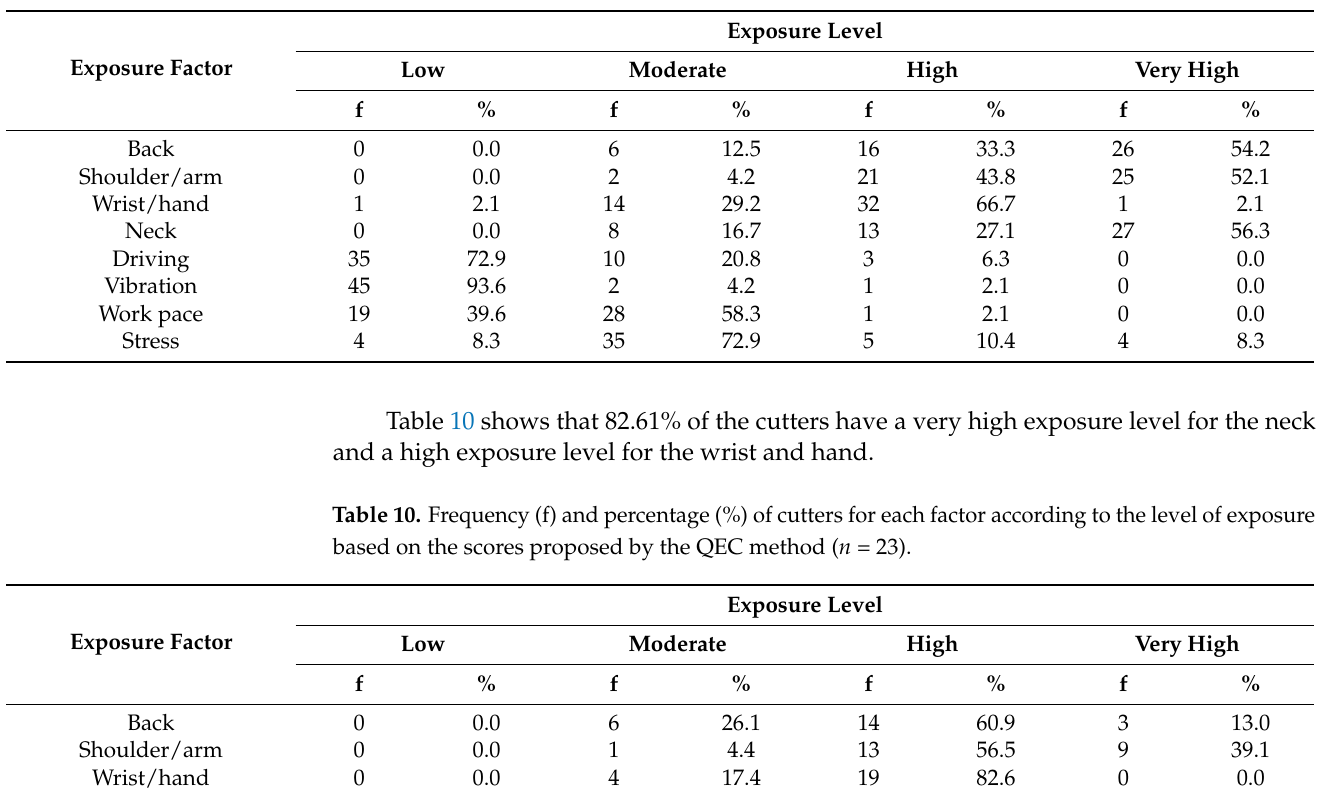
Table 9. Frequency (f) and percentage (%) of workers for each factor according to the level of exposure based on the scores proposed by the QEC method ( n = 48).